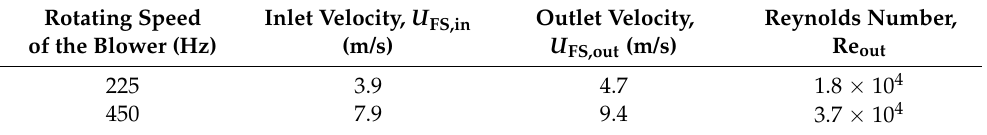
Table 3. Inlet and outlet freestream velocities and Reynolds numbers of the linear turbine cascade.